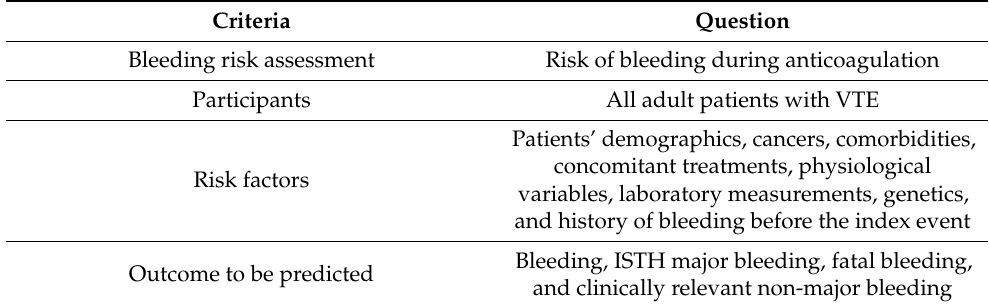
Table 1. Pilot question form.